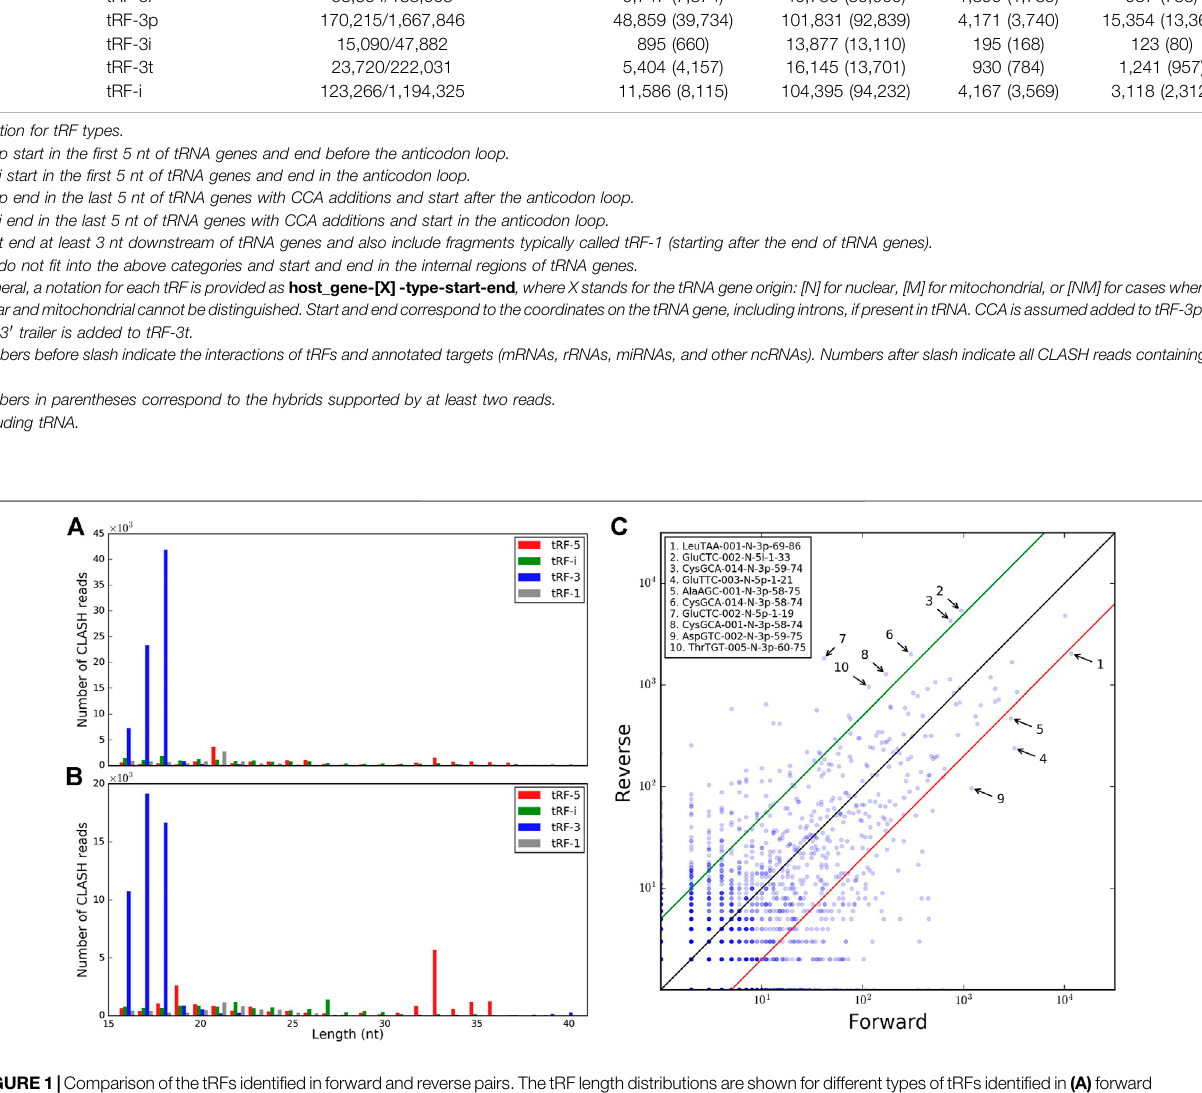
FIGURE1| ComparisonofthetRFsidenti fi edinforwardandreversepairs.ThetRFlengthdistributionsareshownfordifferenttypesoftRFsidenti fi edin (A) forward pairs and (B) reverse pairs. (C) Relative frequencies of tRFs common to forward and reverse chimeras. The 10 most abundant tRFs with the highest differential frequencies in the two orientations (fold change > 5) are